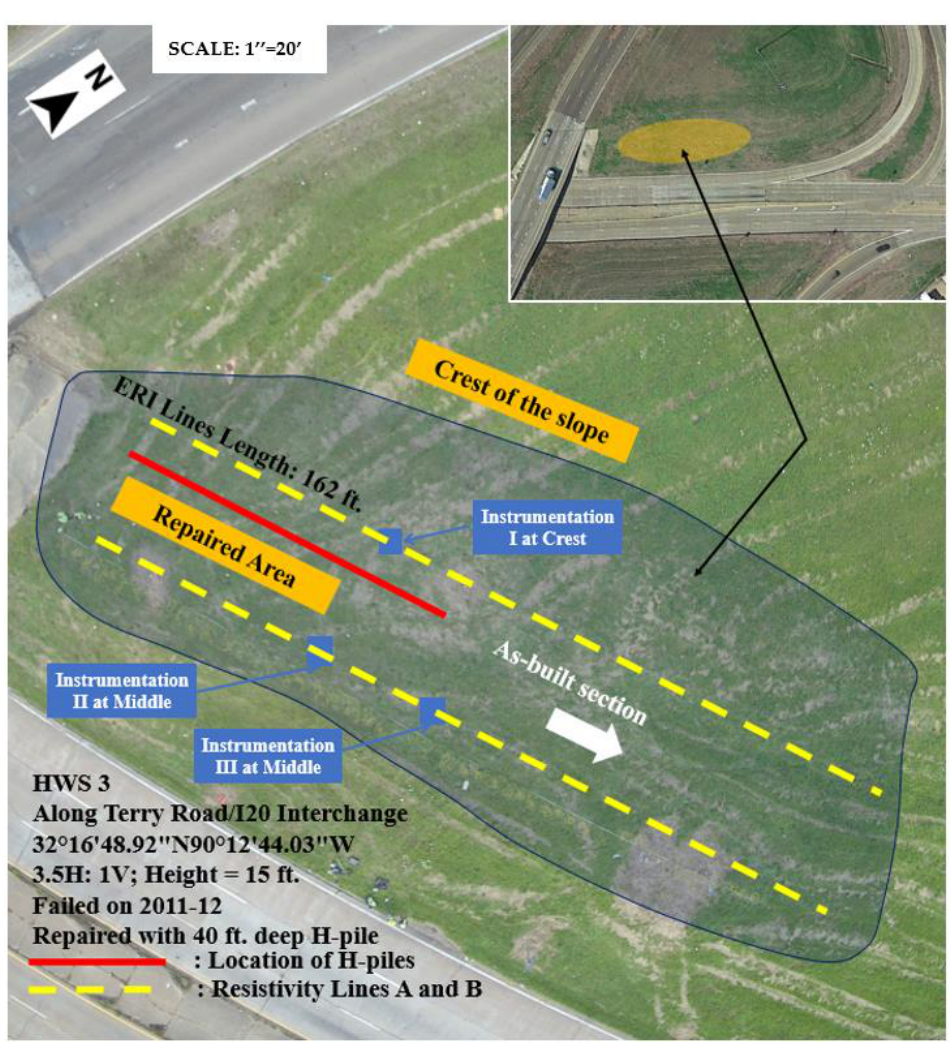
Figure 16. HWS 3 ERI and instrumentation layouts along with its characteristics (drone image-top view) ( 1′ = 1 ft = 0.305 m).